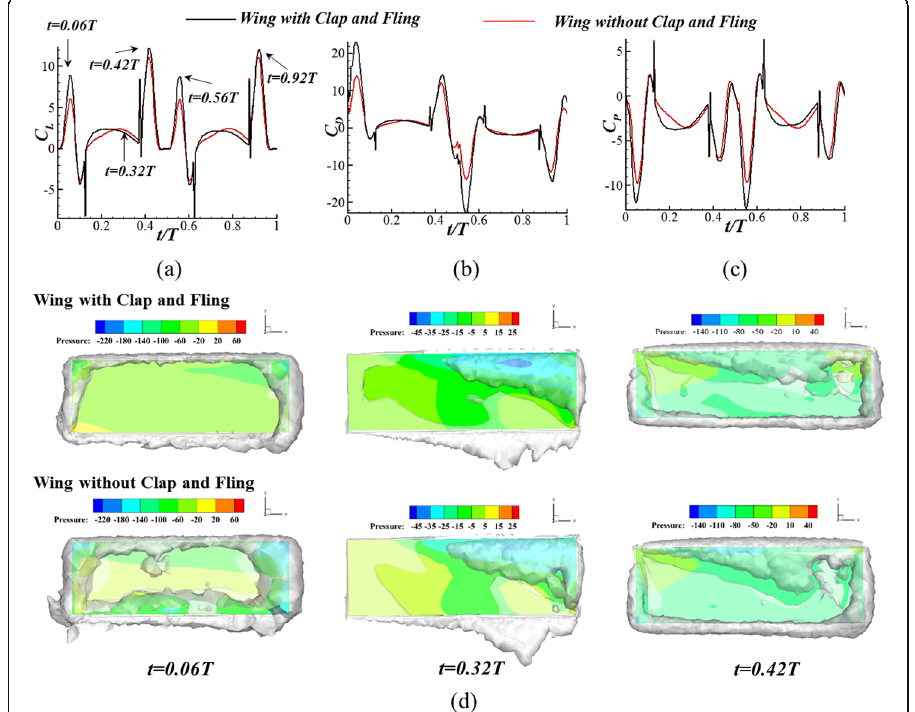
Fig. 7 Aerodynamics, pressure distribution and flow field of the flapping wing with or without clap-and- fling effect in typical time. a - c lift, drag, aerodynamic power coefficient changes during a stroke cycle, ( d ) pressure distribution of typical